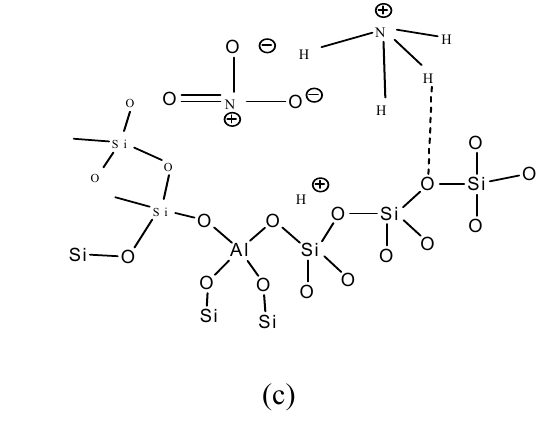
Figure 5. The structures of: (a) NH between NH